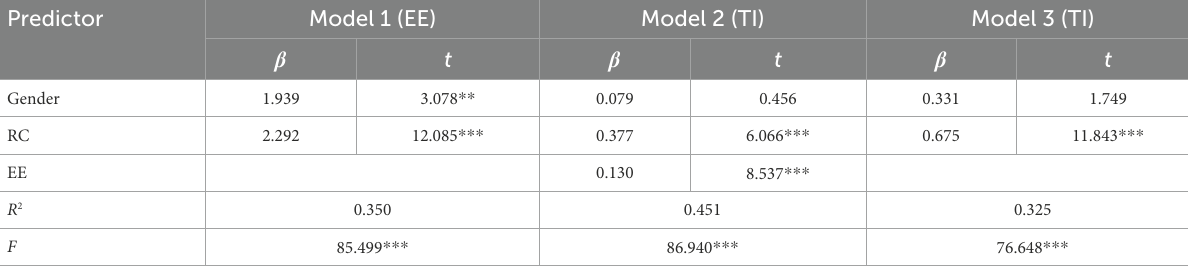
TABLE 4 Testing the mediating effect of role conflict on turnover intention.